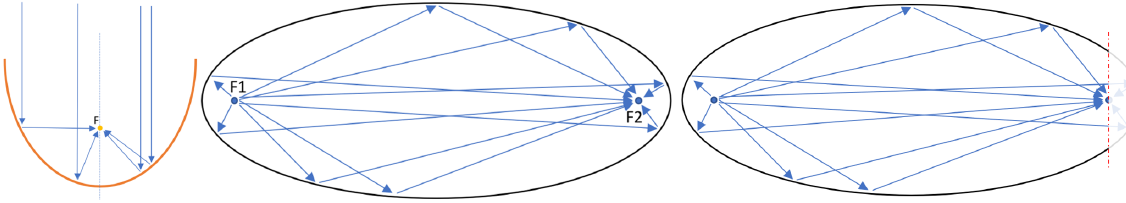
Figure 2. The reflecting characteristics of a parabola and an ellipse are visualised. All parallel rays entering a parabolic reflector will be focussed on the focal point. Each ray leaving one focal point of the ellipse will be reflected to the other focal point of the ellipse. One can see that cutting the ellipse on the red line will result in rays not being reflected by the elliptical shape towards the second focal